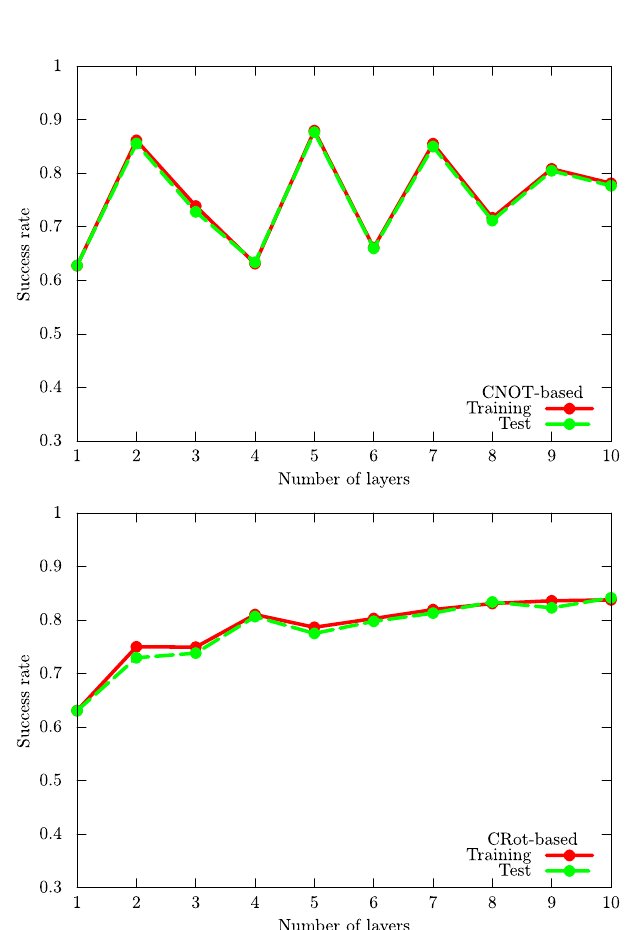
Figure 3. Performance dependence of QCL on the number of layers L for the cancer dataset (0 or 1). We use the CNOT-based (upper panel) and CRot-based (lower panel) circuit geometries and set θ bias = 0 .